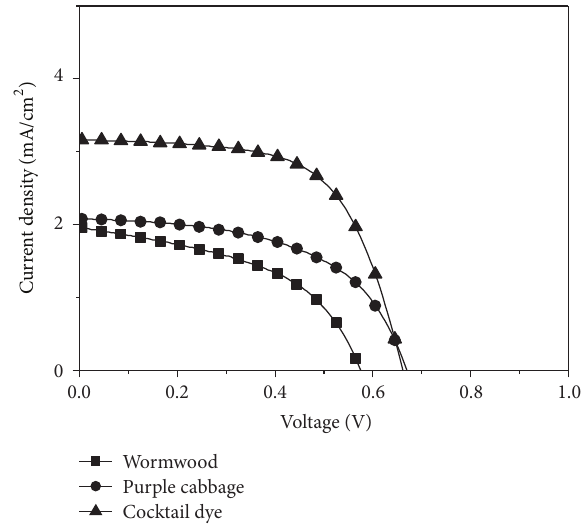
Table 3: Photoelectrical parameters of DSSCs sensitized by cocktail dyes with different thicknesses of TiO